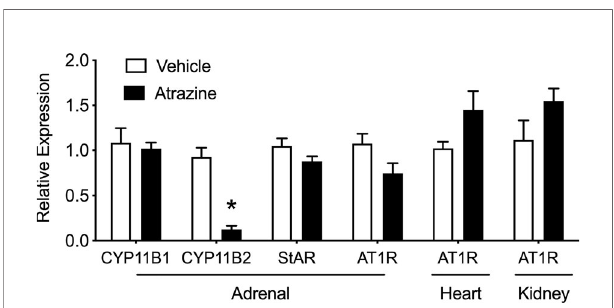
FIGURE 6 | Effects of atrazine treatment on select gene expression of the adrenal, heart and kidney. Histogram depicting the fold change expression of CYP11B1 (11 b -Hydroxylase), CYP11B2 (aldosterone synthase), steroidogenic acute regulatory (StAR) protein, angiotensin II receptor type 1 (AT 1 R) expression in the adrenal, heart, and kidney of vehicle (clear bar) or atrazine (black bar, 100 mg/kg). Data presented as the mean ± SEM. Asterisk signi fi es difference from control group ( P <